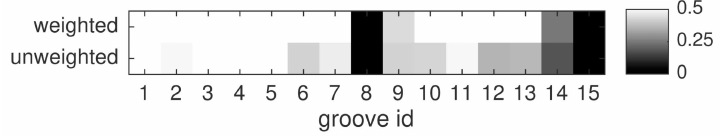
Figure 13. Comparison between the weighted approach (as proposed; top row) and the unweighted variant, for the product fusion rule.